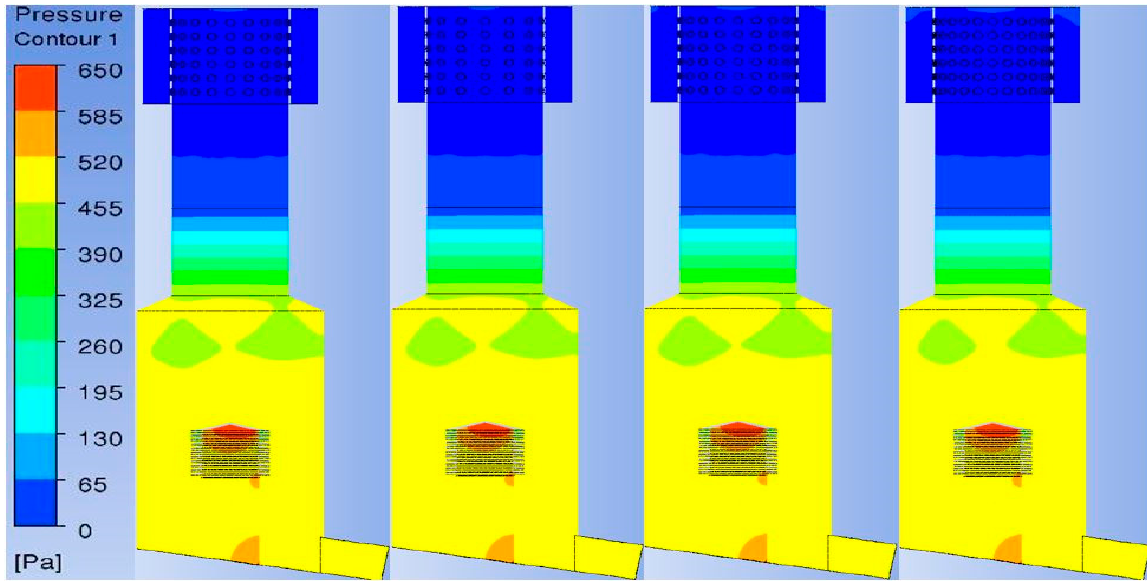
Figure 30. Pressure contour according to the number of holes in the outer resonate type.